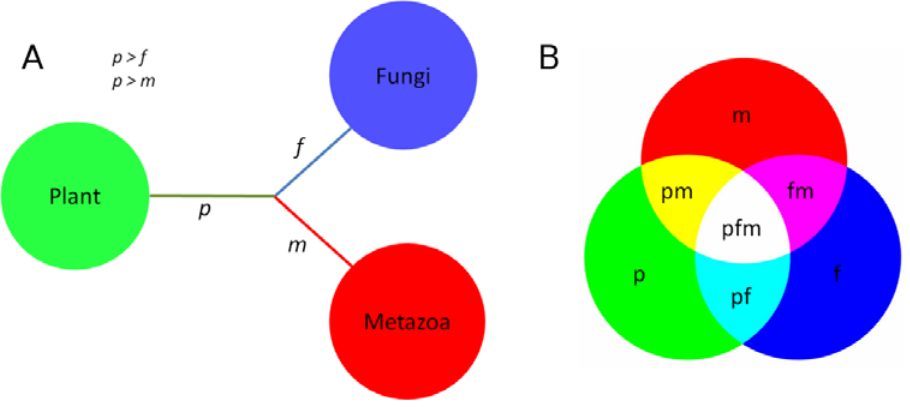
Figure 1. Clade comparison and color code definitions. ( A ) Tree of Life topology of the clades compared here: a more recent common ancestor is known between fungi and metazoans ( Opisthokonta clade); ( B ) color code for clade